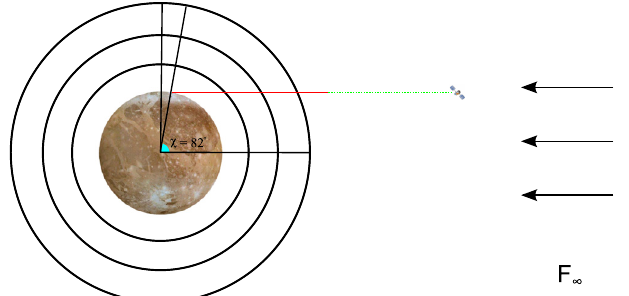
Fig. 2. Line of sight for the Ganymede case.